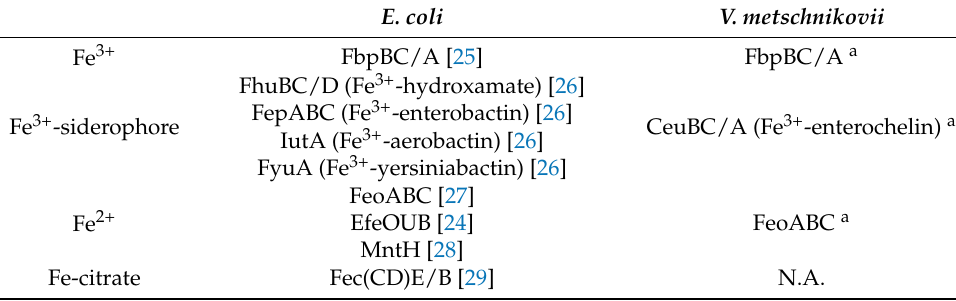
Table 1. Comparison of transporters involved in the uptake of different iron sources. E. coli V. metschnikovii Fe 3+ FbpBC/A [25] FbpBC/A a FhuBC/D (Fe 3+ -hydroxamate) [26] FepABC (Fe 3+ -enterobactin) [26] CeuBC/A (Fe 3+ -enterochelin) a Fe 3+ -siderophore IutA (Fe 3+ -aerobactin) [26] FyuA (Fe 3+ -yersiniabactin) [26] FeoABC [27] EfeOUB [24] FeoABC a MntH [28] Fe-citrate Fec(CD)E/B [29]